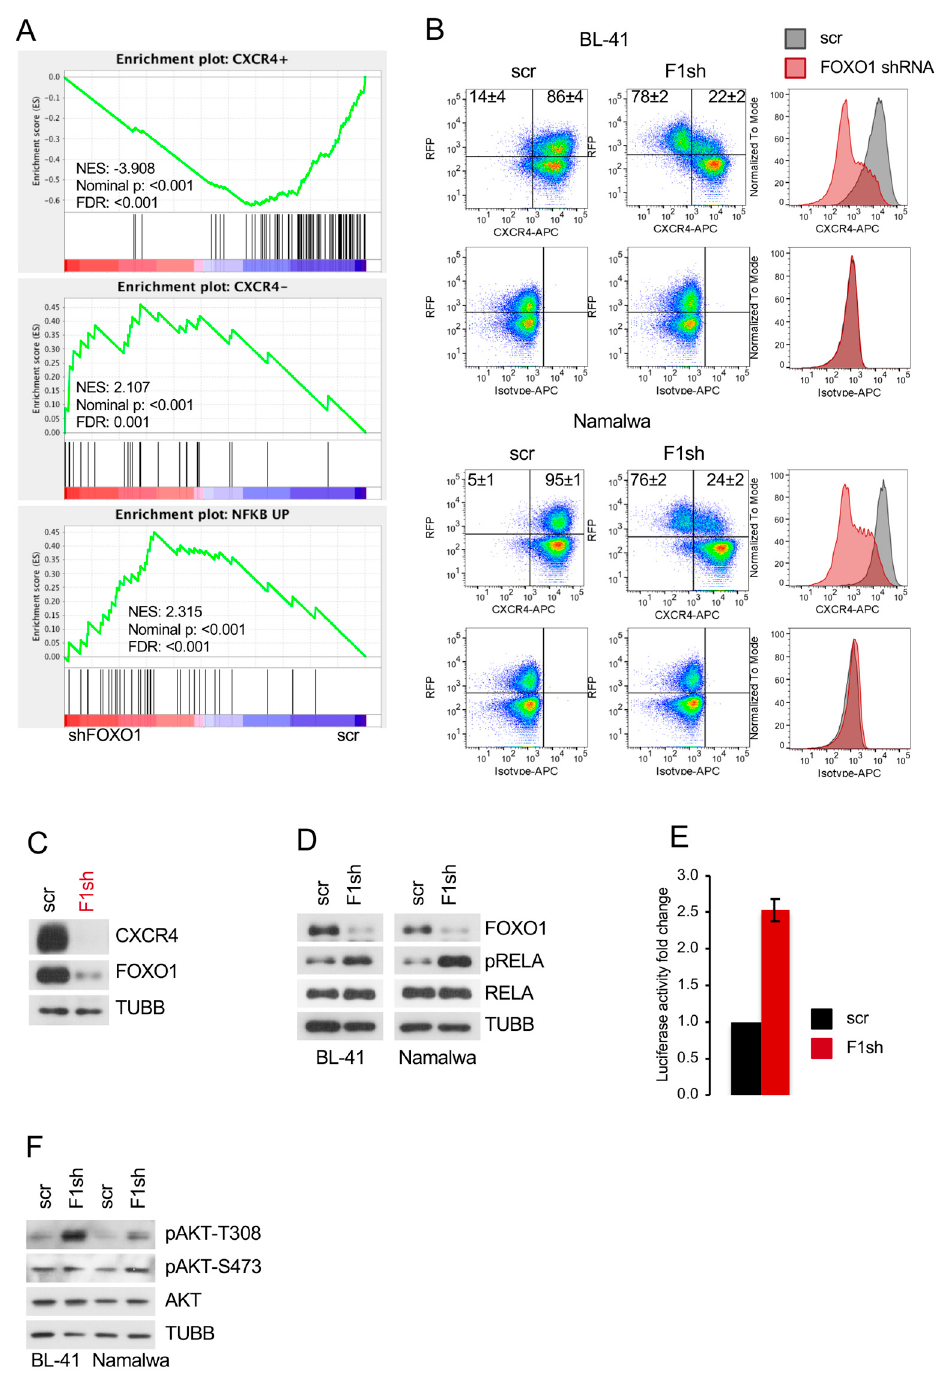
Figure 3. FOXO1 knockdown induces loss of the DZ program and PI3K-AKT and IKK-NF- κ B activation. ( A ) GSEA. Gene signatures comprising genes differentially expressed genes in CXCR4 + centroblasts vs. CXCR4 - centrocytes [36] and gene signature comprising genes differentially expressed in Ramos cell line transfected with constitutively active CA-IKK2 vs. EV control [40] were applied on set of genes modulated more than 1.5 fold by FOXO1 knockdown (threshold of 1.5, ANOVA, Benjamini and Hochberg correction, adjusted p < 0.05). Direction of phenotype comparison: “F1sh vs. scr” (Tables S13, S14, S17). ( B ) F1sh downregulates CXCR4. BL cell lines expressing F1sh or scr control were stained with CXCR4-APC or isotype control 7 days post transduction. Dot-plots show percentages of CXCR4 + /RFP + and CXCR4 - /RFP + cells. For histograms, only transduced RFP + cells were included. Data are shown as mean ± SD ( n = 3). ( C ) BL-41 cell line expressing F1sh or scr control was FACS sorted 4 days post transduction and CXCR4 levels were analyzed by immunoblot. TUBB served as loading control. A representative of 2 independent experiments is shown. ( D ) FOXO1 knockdown